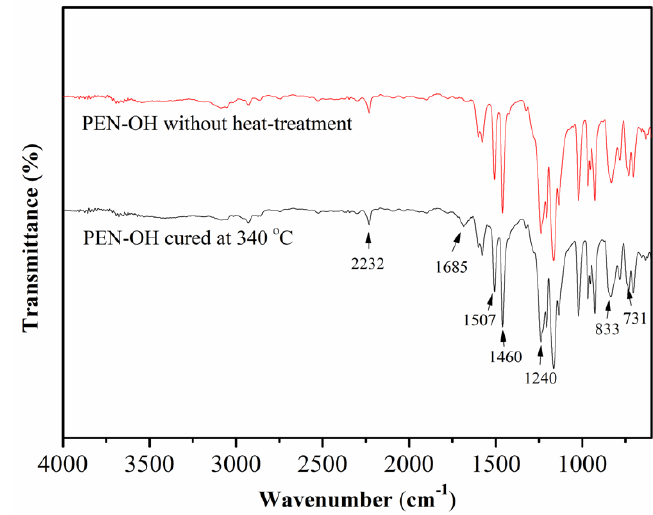
Figure 3. FTIR spectra of the PEN–OH before and after heat-treatment.